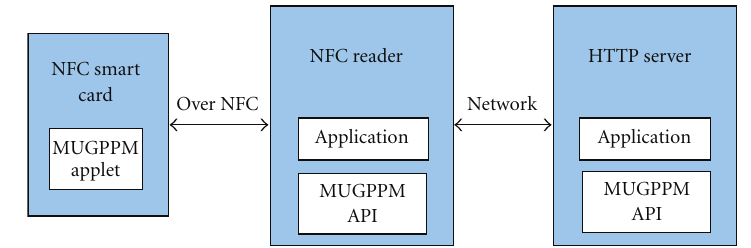
Figure 1: MUGPPM architecture overview.